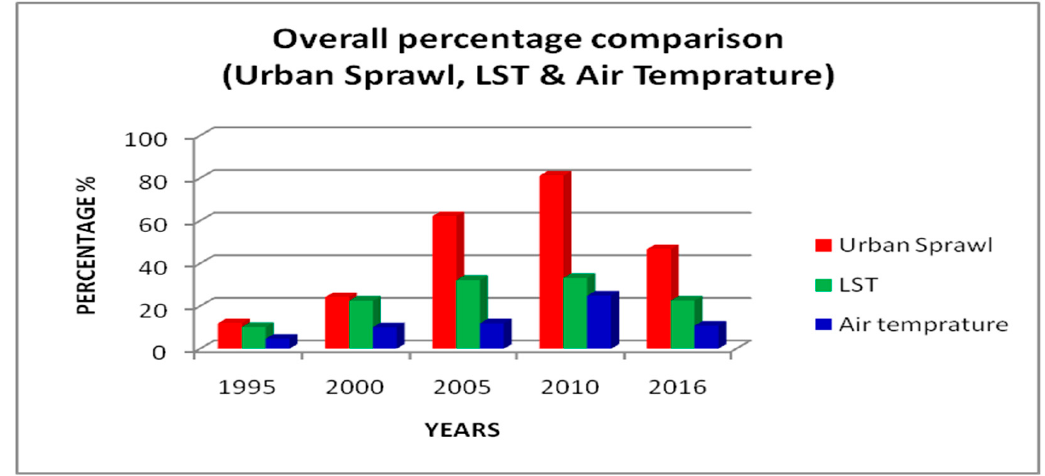
Figure 18. Overall comparison (urban sprawl, LST and air temperature).